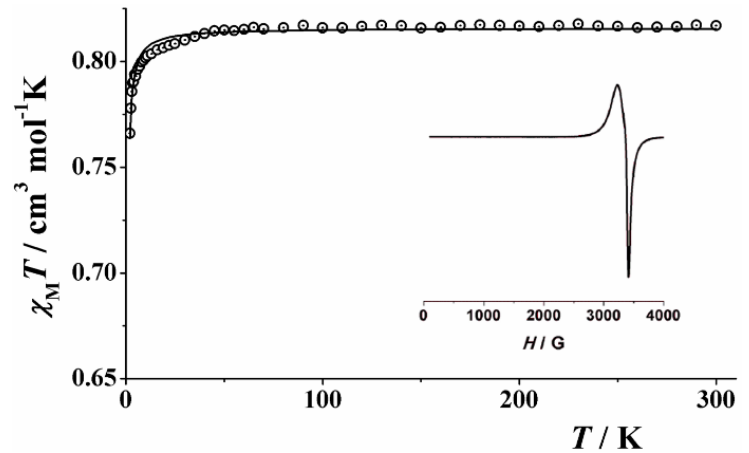
Figure 6. Representation of the  M T as a function of T for 3 . Solid line represents the best fit. Inset, EPR spectrum measured at X-band frequency. EPR spectrum measured at X-band